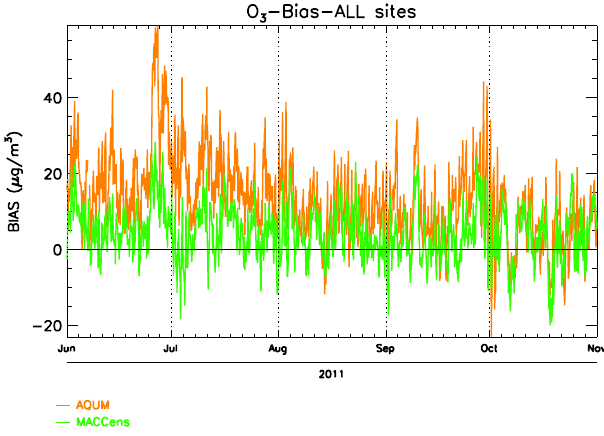
Fig. 18. Time series of hourly ozone bias for AQUM operational output in orange and MACC ensemble in green. Table 6. Performance metrics for AQUM and MACC ensemble ozone forecasts for the period 1 June to 31 October 2011. The small differences in the means and standard deviations of the observations used for evaluating AQUM and the MACC ensemble are due to mi- nor variations in data availability over the period.